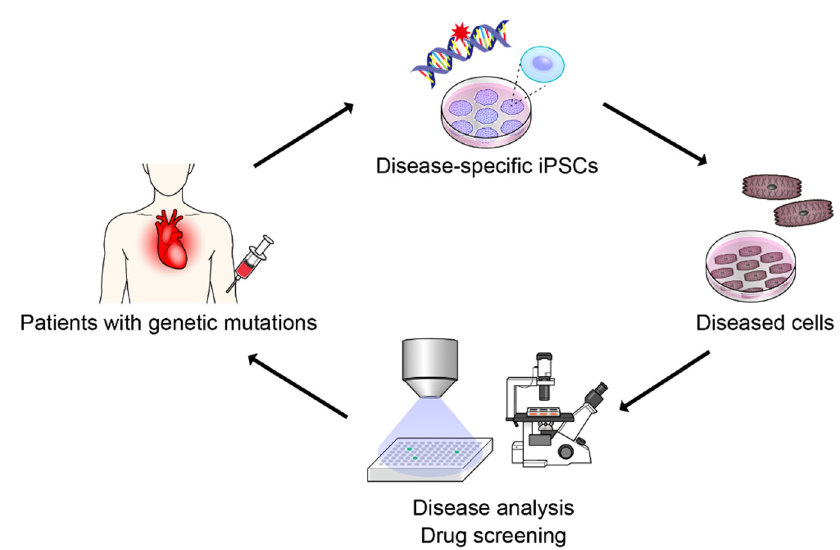
Figure 1. Disease modeling with induced pluripotent stem cells.: Disease-specific iPSCs were generated from the patients with genetic mutations. iPSCs have the same genetic mutations as patients; therefore, differentiated cells from iPSCs can recapitulate the cellular phenotype of patients. Thus, disease-specific iPSCs can be used for disease analysis and drug screening of genetic diseases.